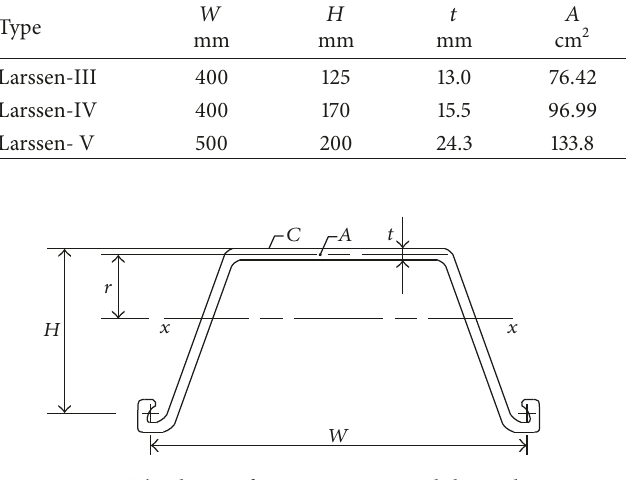
Figure 1: The shapes of U-type Larssen steel sheet piles.